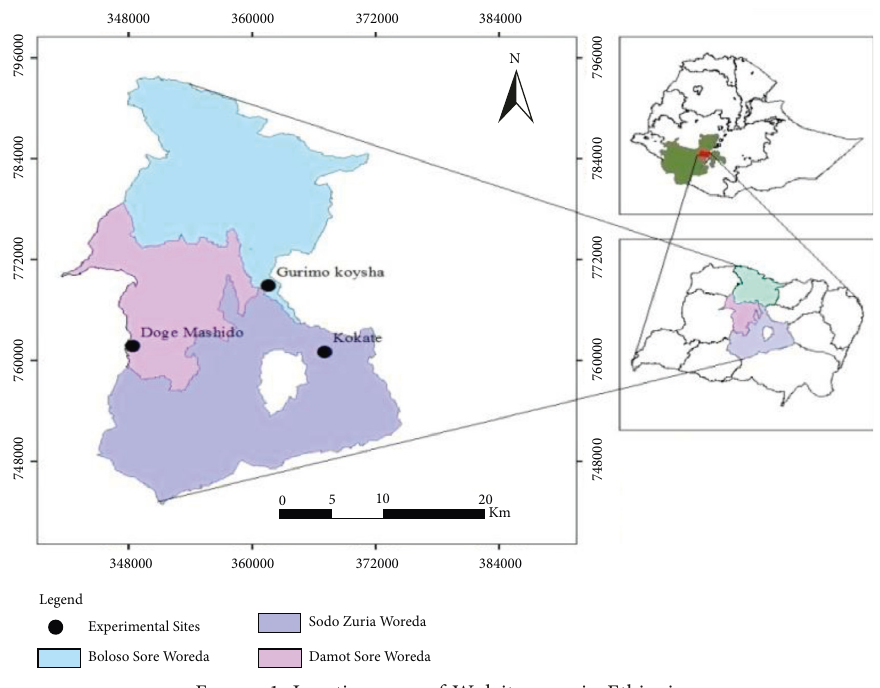
Figure 1: Location map of Wolaita zone in Table 1: Monthly average means of rainfall and temperatures of the study areas during growth season.